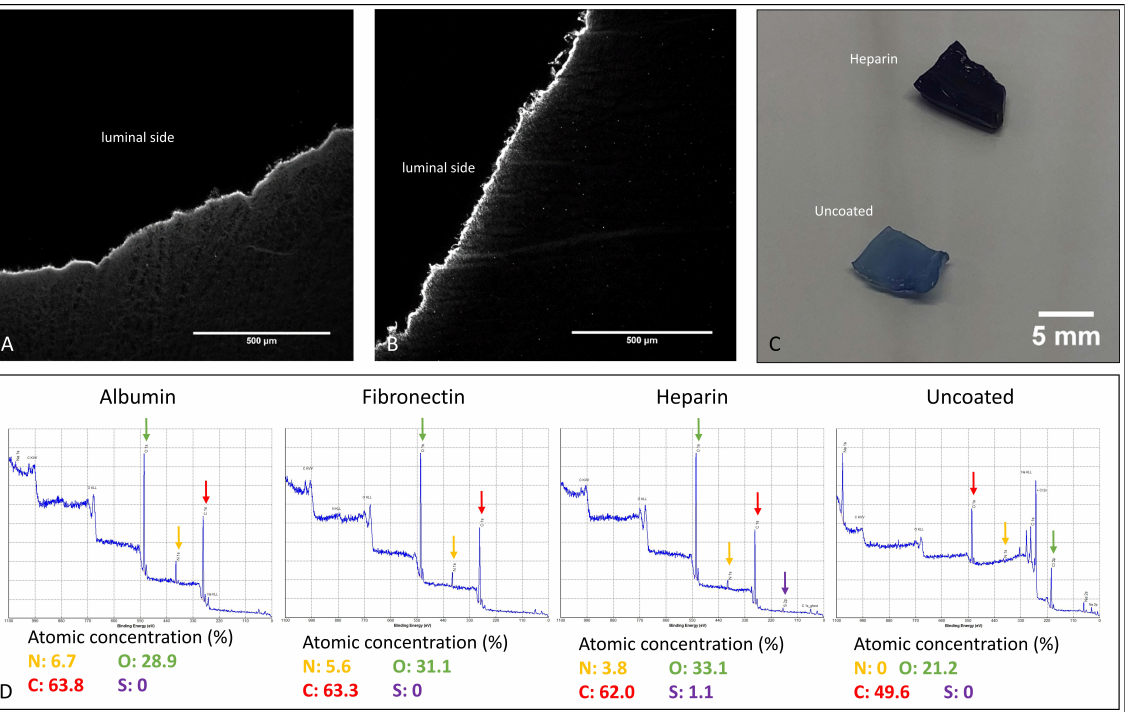
Figure 2. Coating analyses of exemplary coated BNC grafts: ( A ) Immunofluorescence staining of a cross-sectioned BNC graft against albumin. ( B ) Immunofluorescence staining of a cross-sectioned BNC graft against fibronectin. ( C ) Comparison of toluidine blue staining for heparin-coated and uncoated BNC grafts. ( D ) Results of XPS analyses of the coated BNC grafts. The colored arrows indicate the respective peaks for N (nitrogen), O (oxygen), C (carbon), and S